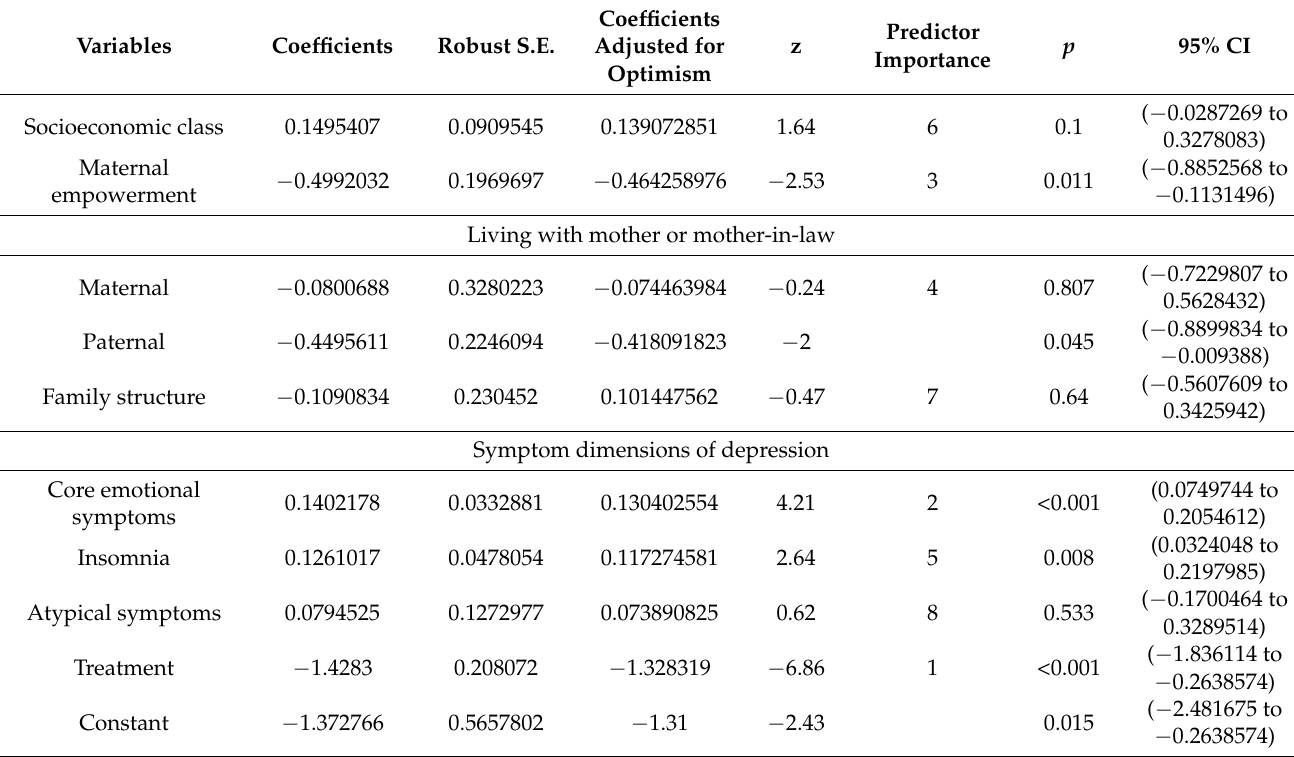
Table 2. Logistic regression analyses for predicting remission in depression.